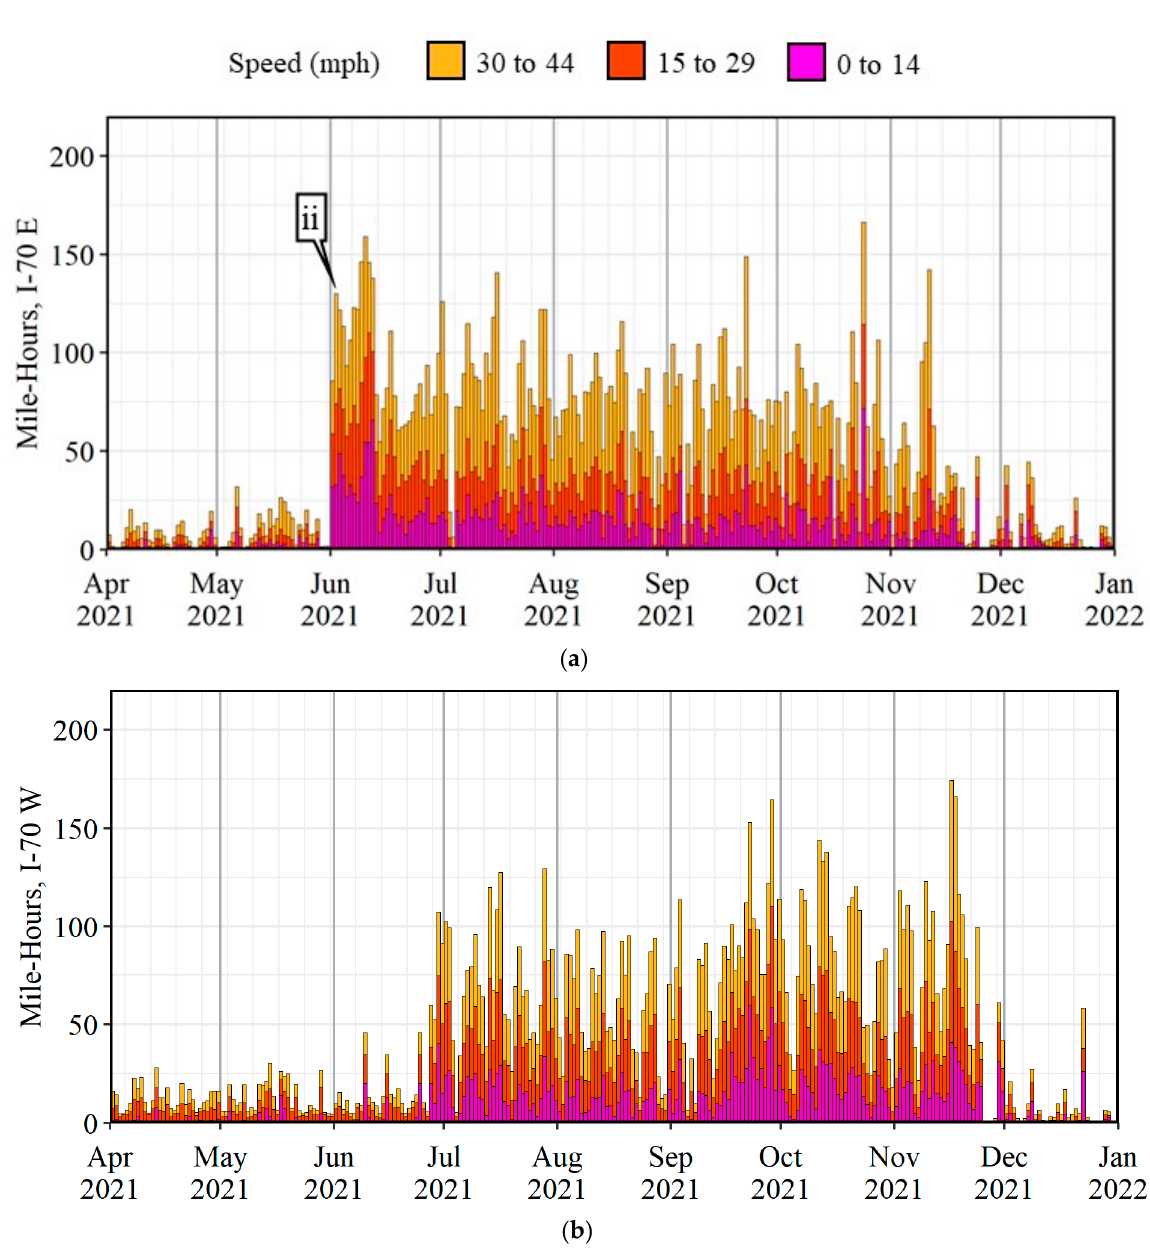
Figure 6. Comparison of hard-braking events across I-465. ( a ) Weekly hard-braking events (Inner Loop); ( b ) Percentage change in hard-braking events from previous week (Inner Loop); ( c ) Weekly hard-braking events (Outer Loop); ( d ) Percentage change in hard-braking events from previous week (Outer Loop).